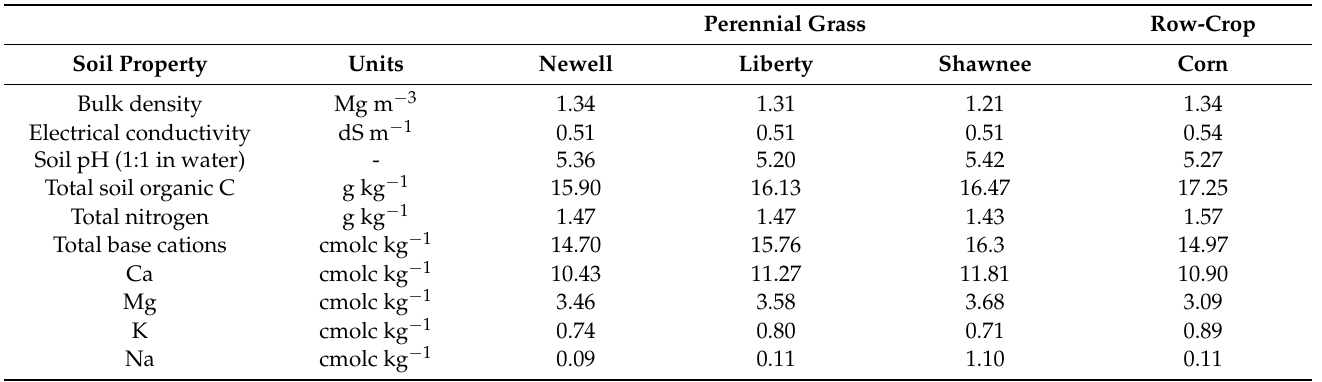
Table 1. Baseline soil properties. Field-level averages for surface soils (0–30 cm depth) at study establishment. Perennial Grass